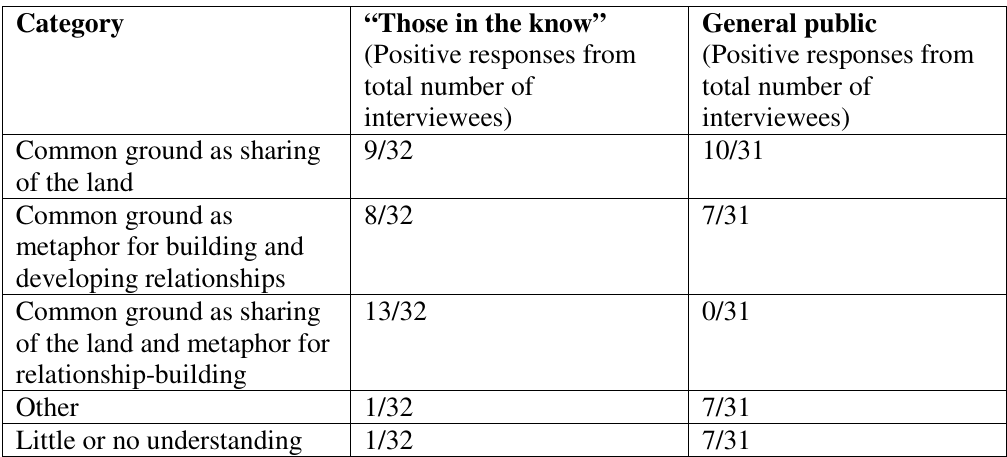
Table 1.2 – Local people’s understanding of common